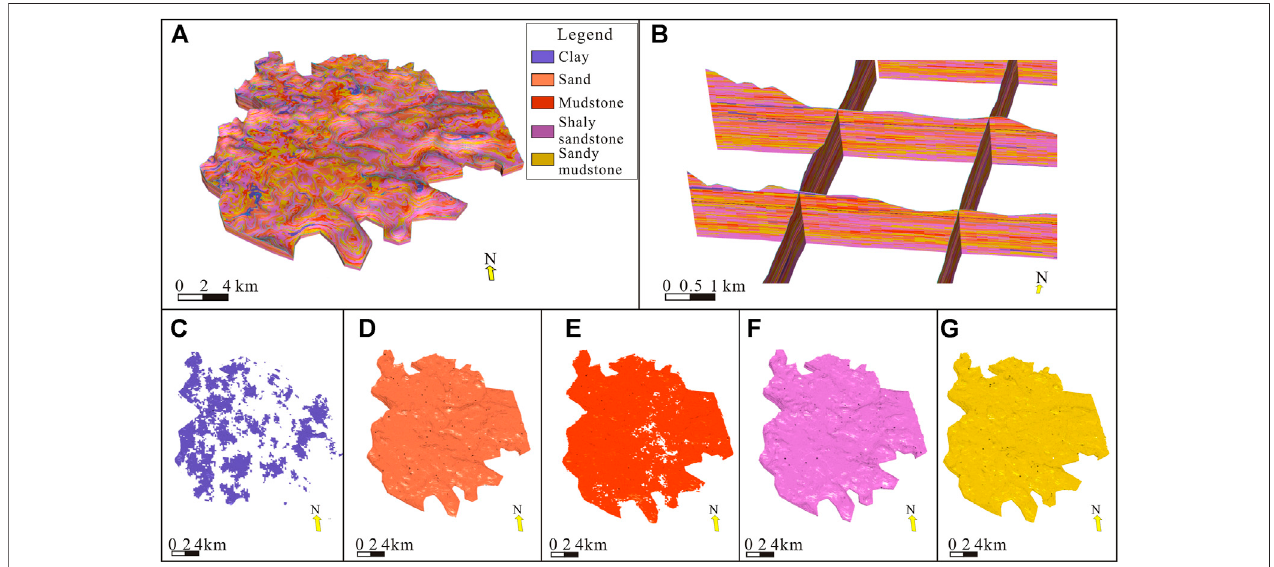
FIGURE 7 | Lithology model (A) , fence diagram (B) , and lithology distribution of the research area (C,D,E,F, and G) .